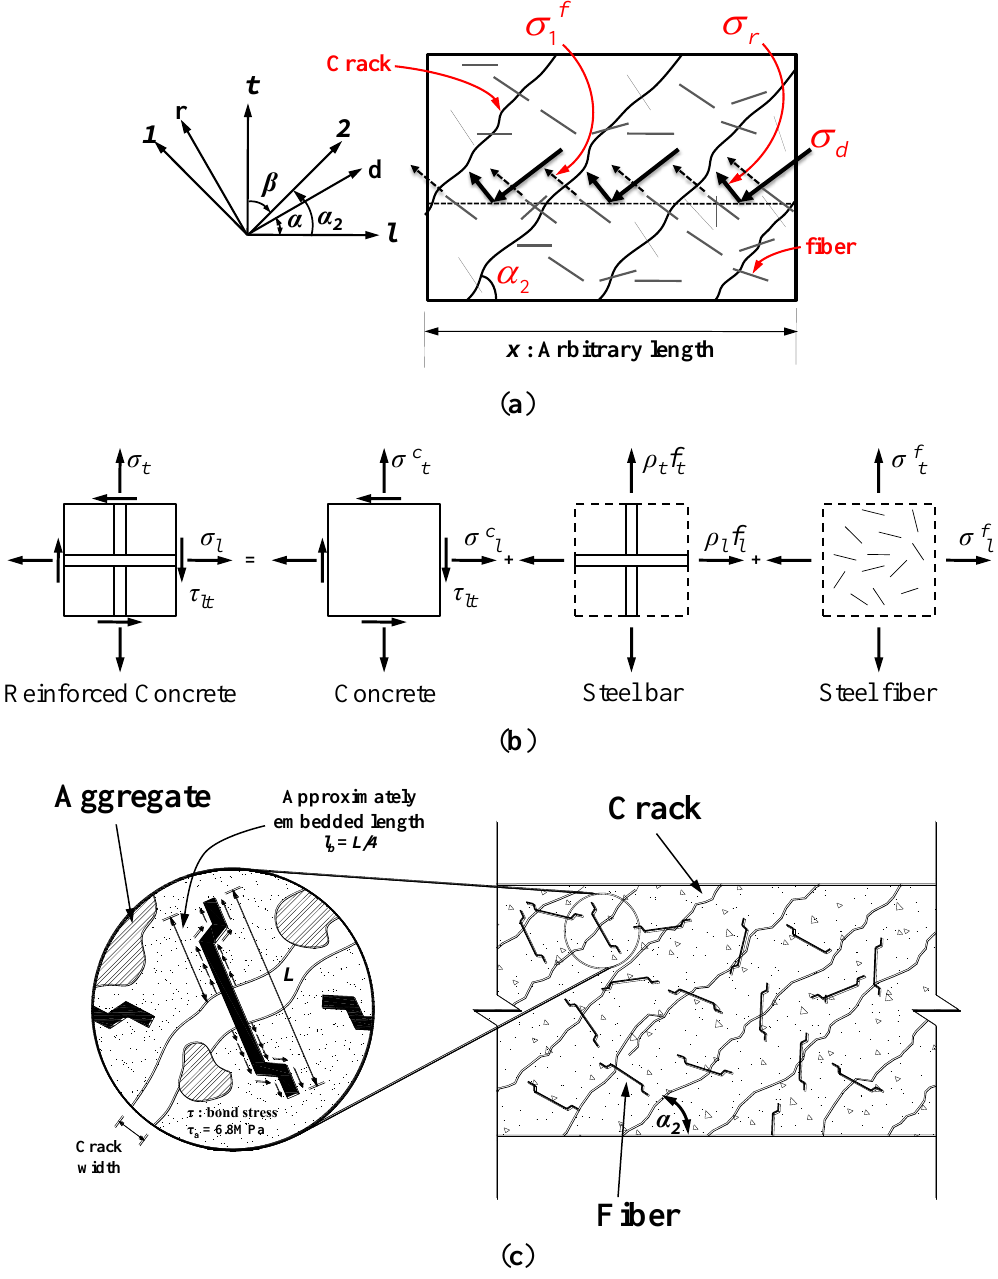
Figure 3. Description of the proposed model for SFRC members. ( a ) Description of steel fibers in cracked concrete; ( b ) Equilibrium in a SFRC element; ( c ) Bonded length of a steel fiber at